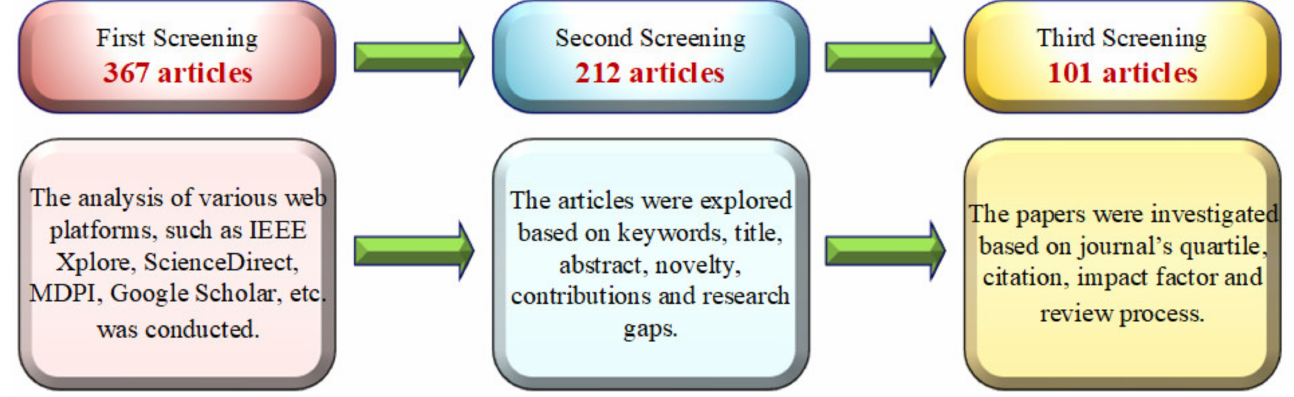
Figure 1. The survey framework for appropriate article selection